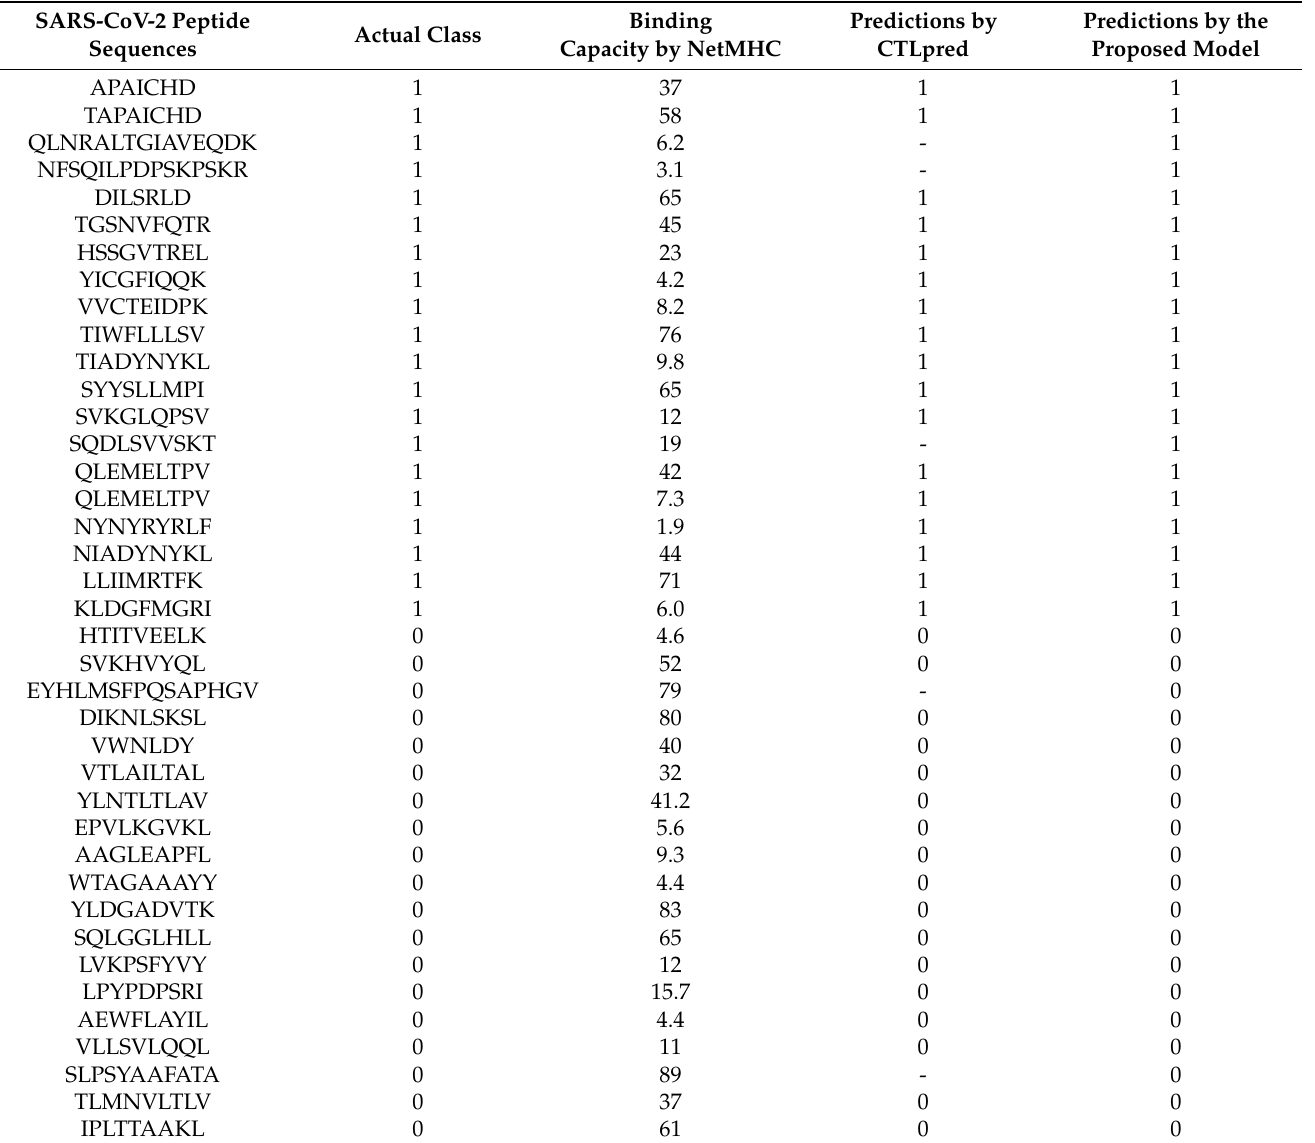
Table 8. Validation results of the proposed ensemble model and its comparison with existing techniques. SARS-CoV-2